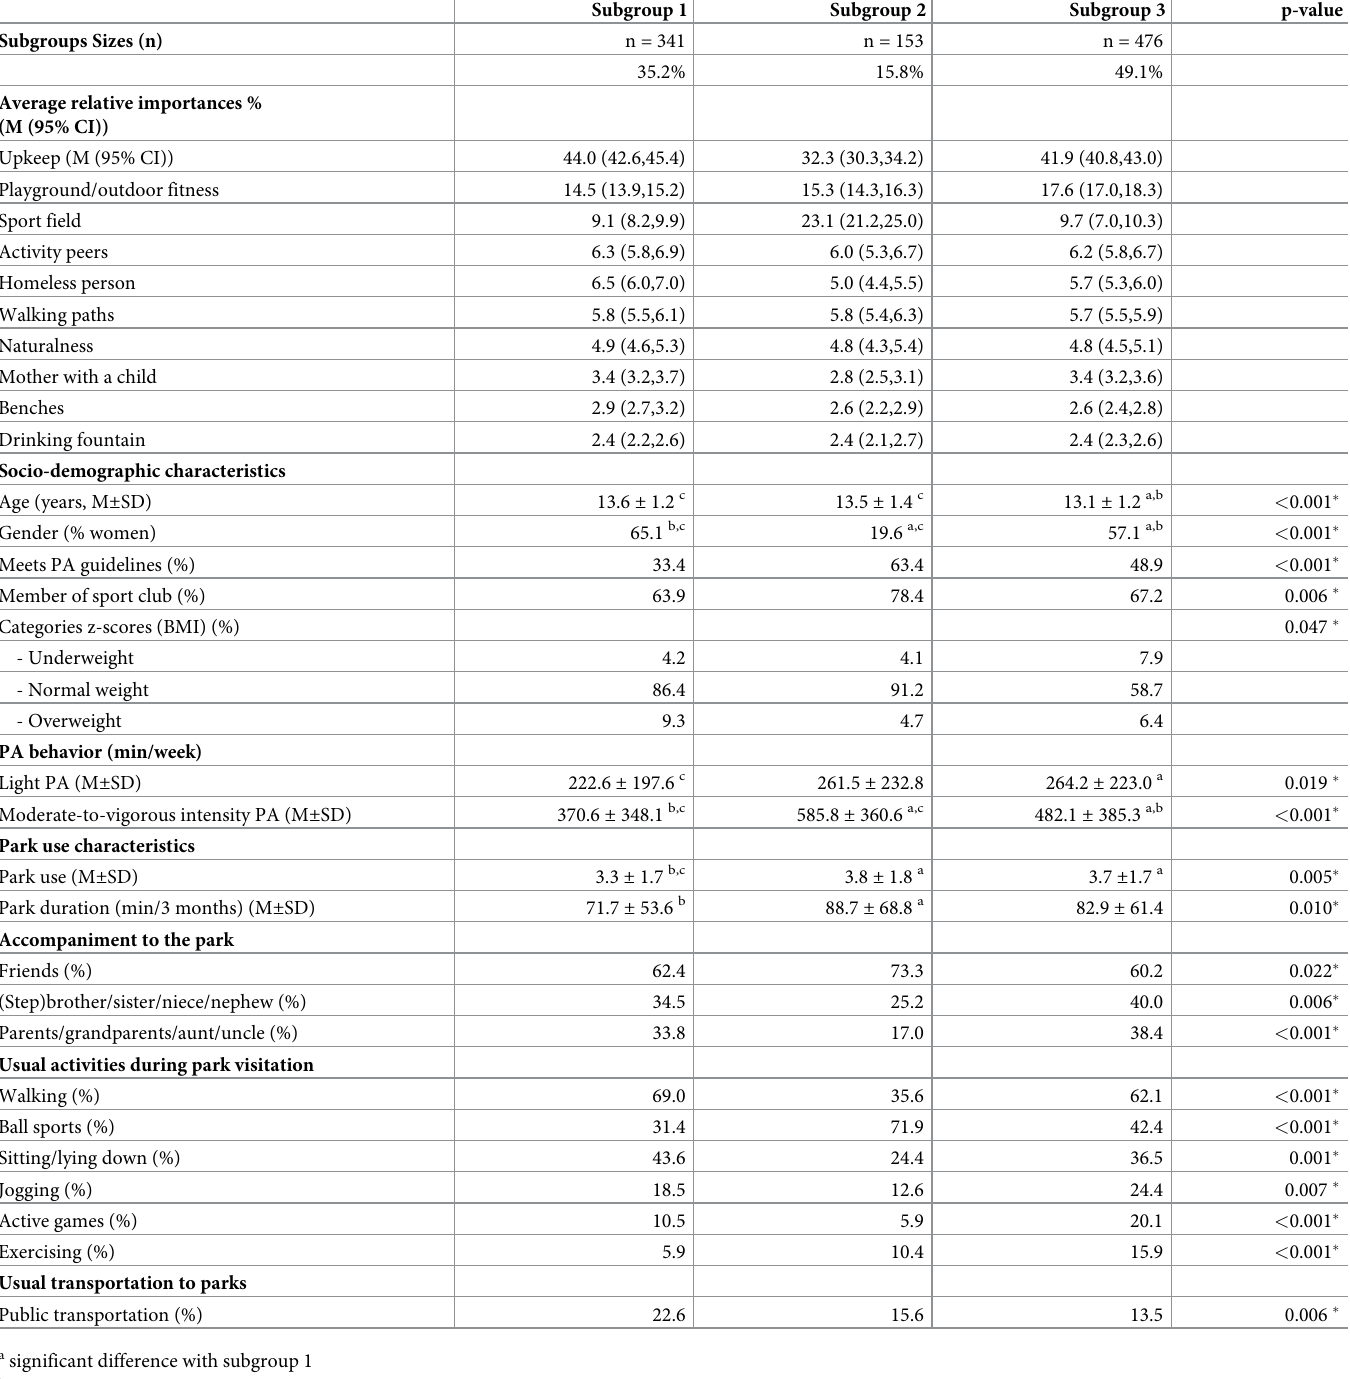
Table 2. Relative importances of each park characteristic for park-based PA, socio-demographics, PA behavior and park use characteristics for the three subgroups identified by latent class